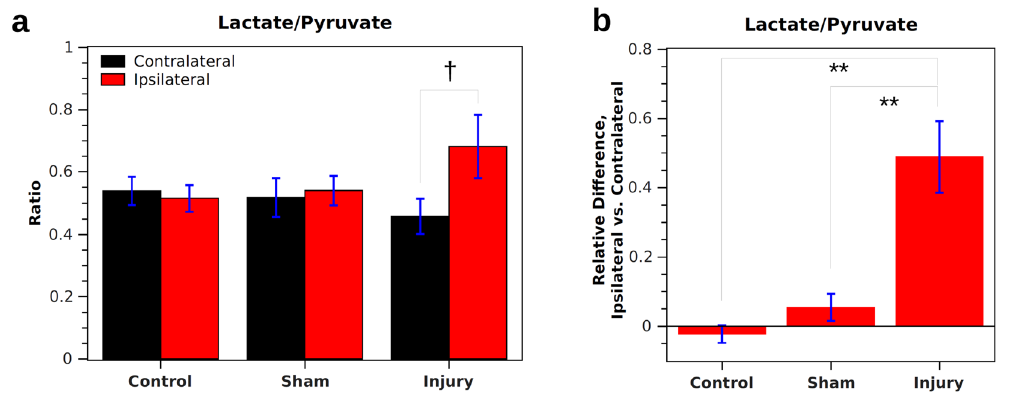
Figure 4. Results for lactate-to-pyruvate ratio in injured, sham, and control rats. ( a ) Integrated values from ipsilateral and contralateral ROIs are similar for sham and control rats. For injured rats, the value is significantly higher on the ipsilateral vs. contralateral side (correlated t -test). ( b ) When considering the relative difference between ipsilateral and contralateral sides, control and sham animals have a similar value on both sides of the brain. Injured animals have a 49 ± 10% higher value on the injured side. ** Indicates p < 0.01 for independent samples. † Indicates p < 0.05 for correlated